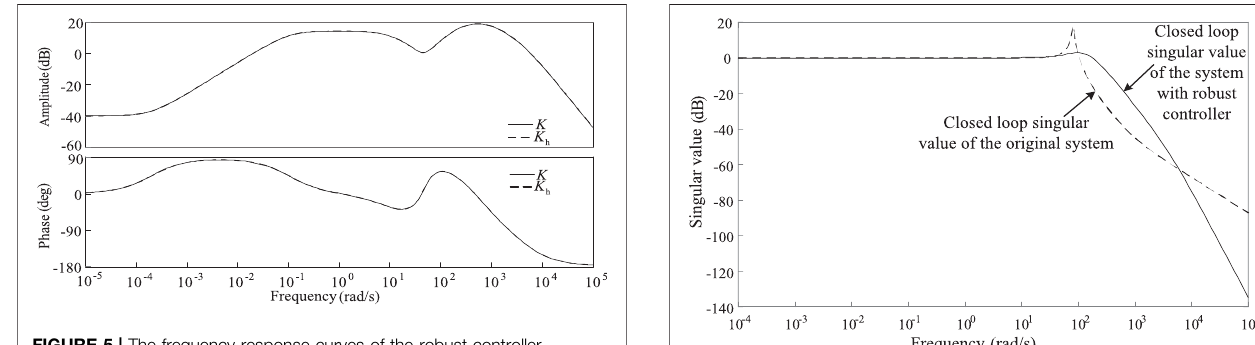
FIGURE 5 | The frequency response curves of the robust controller before order reduction and after order reduction.